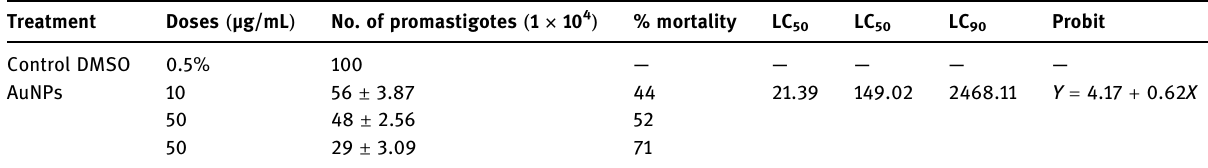
Table 1 The: e ffi cacy of anti - promastigotes ’ various concentrations of SE - mediated AuNPs against L. tropica Treatment